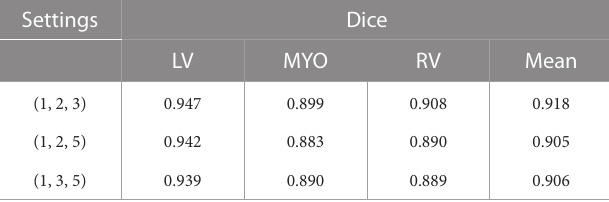
TABLE4 Ablationexperimentswithdifferentdilationratesettings.